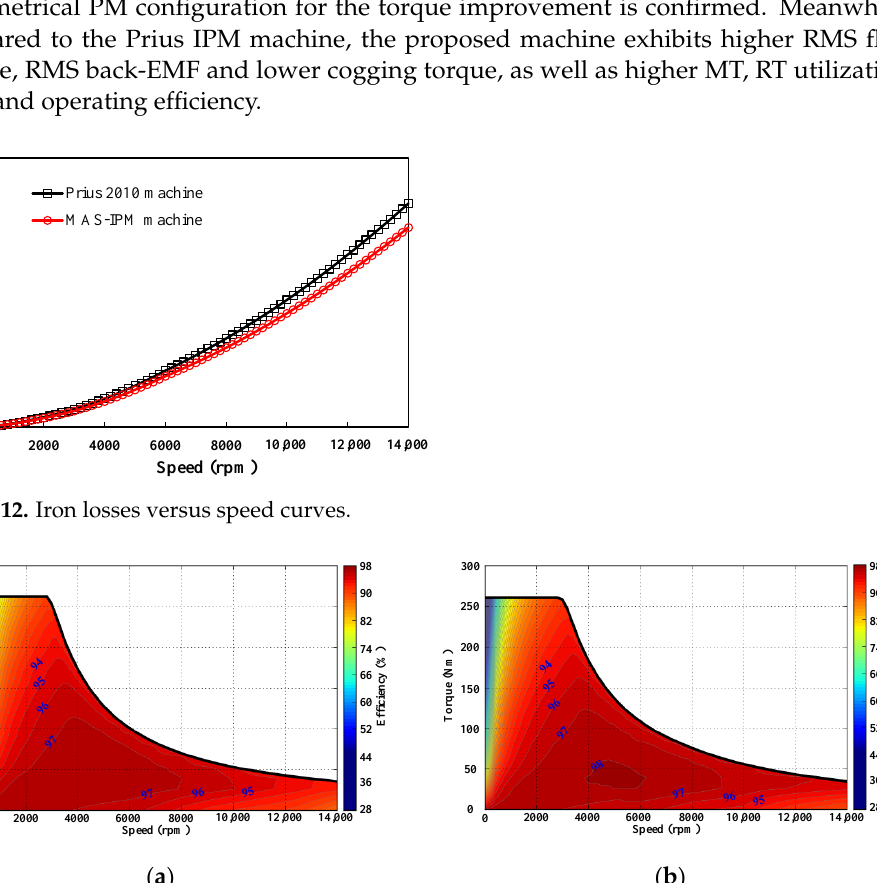
Figure 13. Efficiency maps. ( a ) The Prius 2010 machine. ( b ) The MAS-IPM machine. (I max = 246 A, U dc = 650 V). Table 3. The electromagnetic performance of the two investigated machines. Items